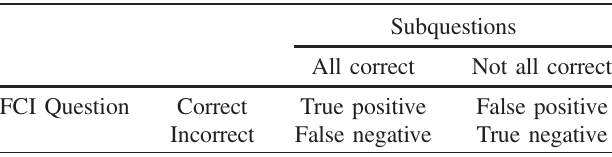
TABLE II. Contingency table of answers with